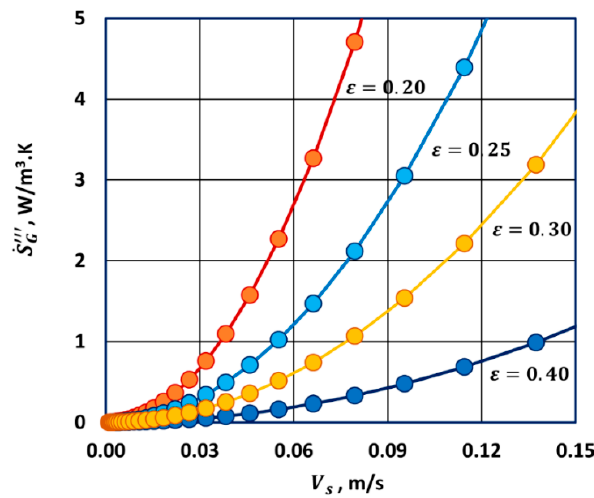
Figure 10. Effect of bed porosity on the rate of entropy generation per unit volume of the packed bed in laminar flow ( T = 298.15 K, d p = 1 mm, µ = 18.5 µ Pa · s, ρ = 1.184 kg / m 3 ). The data points are generated using Equation (50).